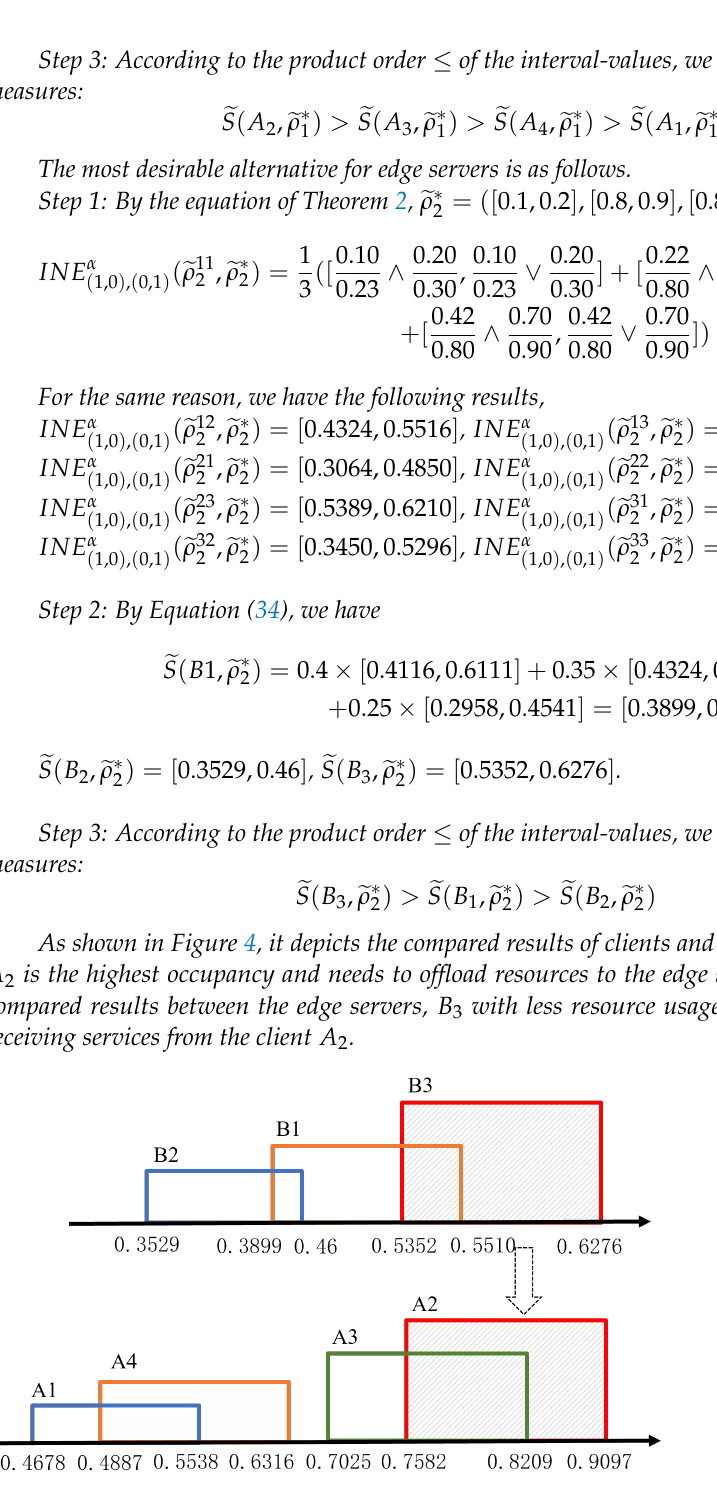
Figure 4. The visualization of the matching